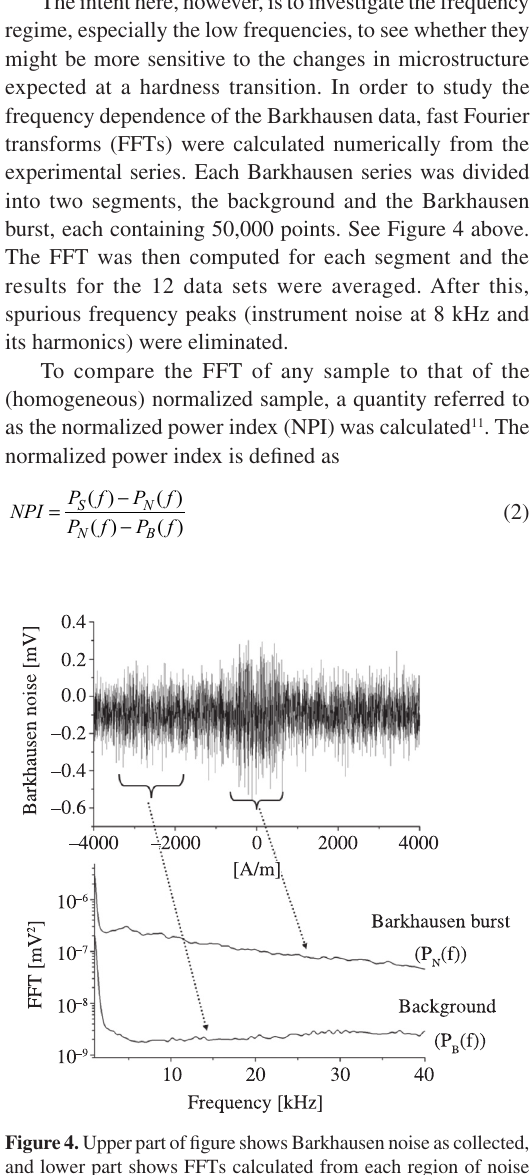
Figure 3. Block diagram of system used to measure Barkhausen noise.